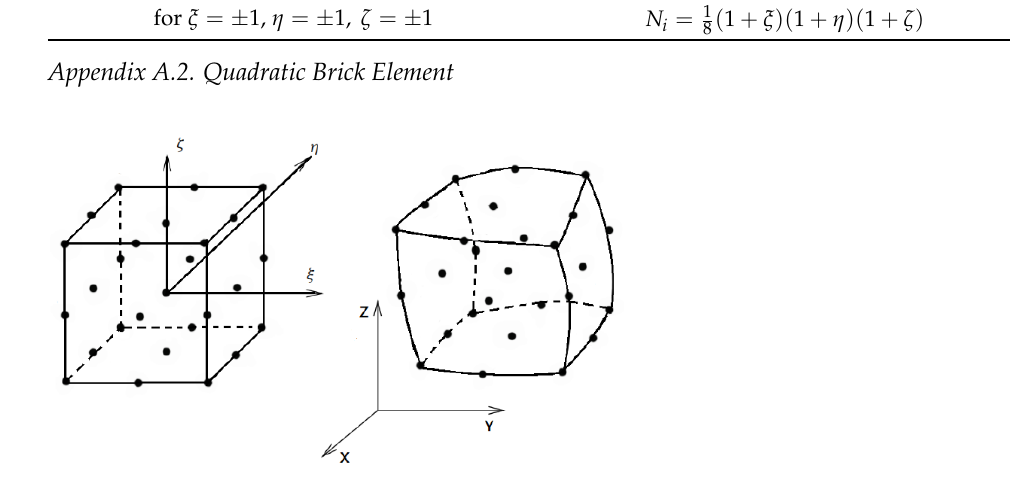
Figure A2. Cartesian global and local curvilinear coordinates of the 27-node brick FE. Table A2. The shape functions of the 27-node brick FE.